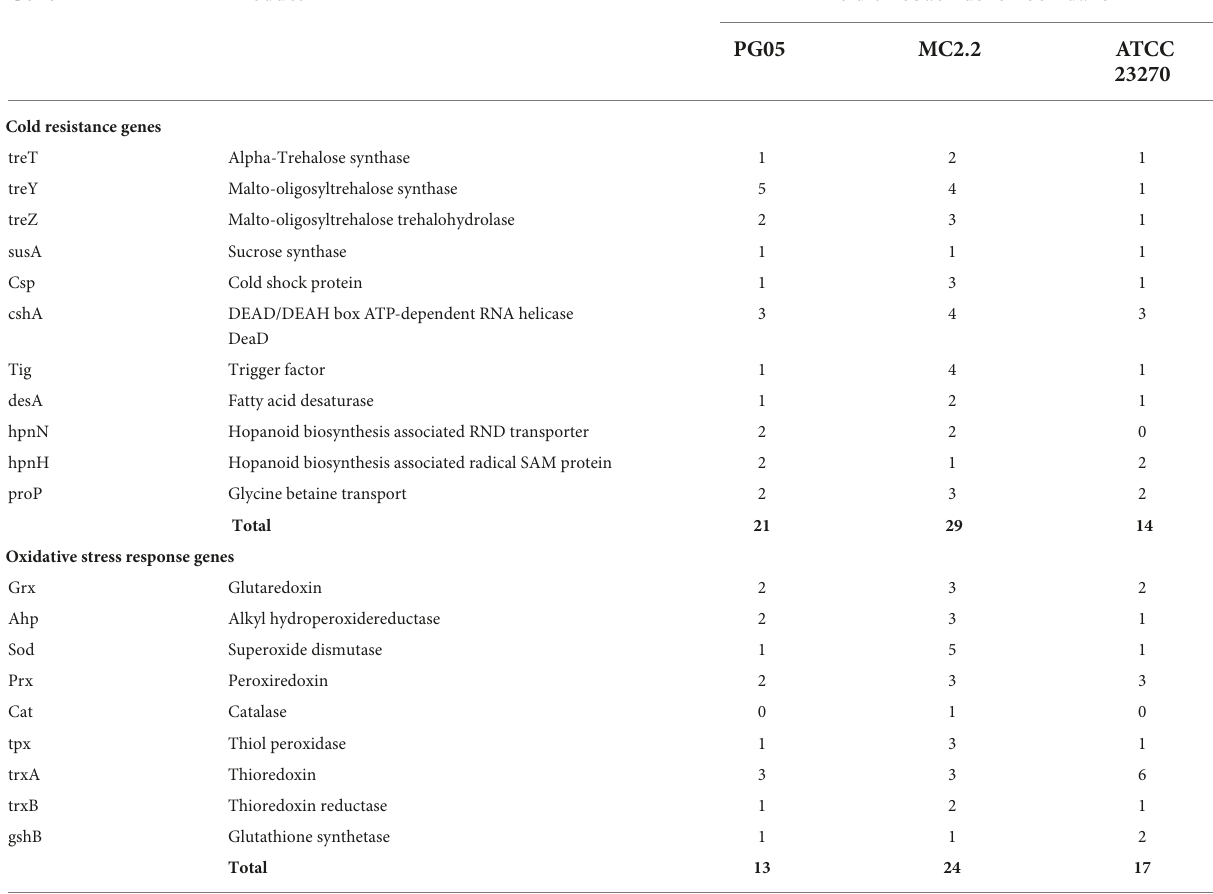
TABLE 5 Genes associated with cold resistance and oxidative stress identified in the genomes of strains PG05 and MC2.2 compared to the type strain ATCC 23270.